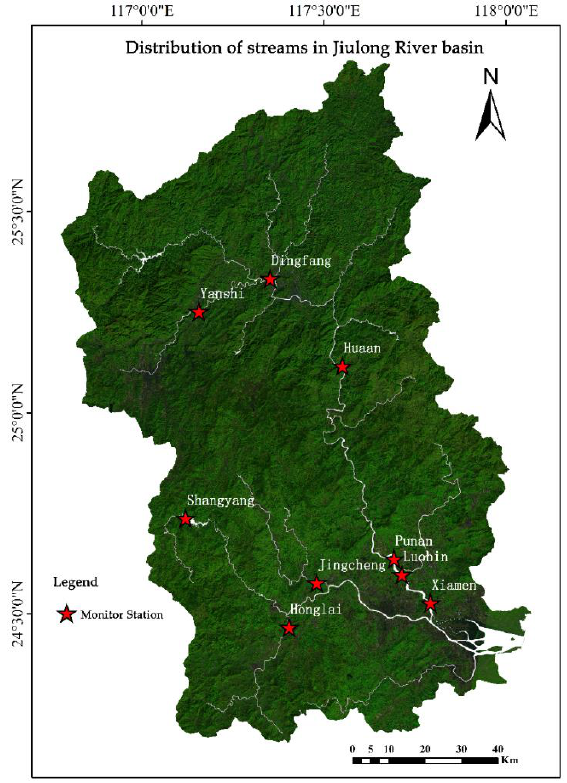
Figure 1. The specific situation of Jiulong River basin. Table 1. Multitemporal images and sensors information